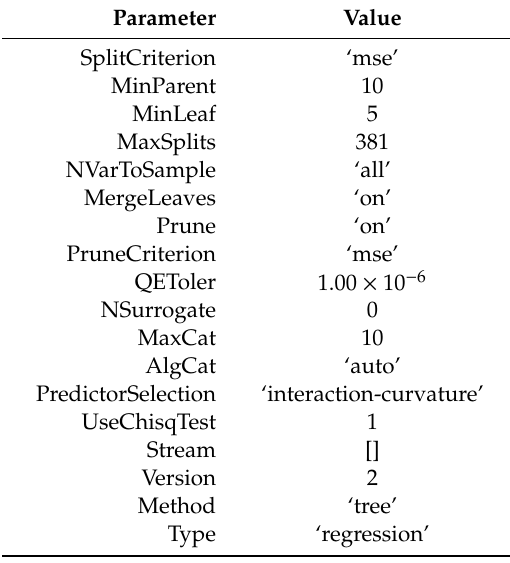
Table 2. Decision tree parameters for ET.